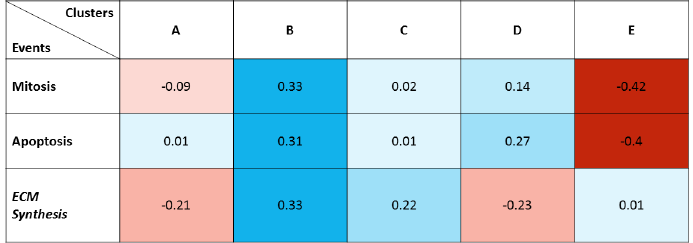
Fig 11. Clusters weights. Relativeweights of the five clusters on each of the 3 biologicalprocesses. Positive weights are mappedin red and negative weight in blue, with tonality from light (low impact) to dark (high